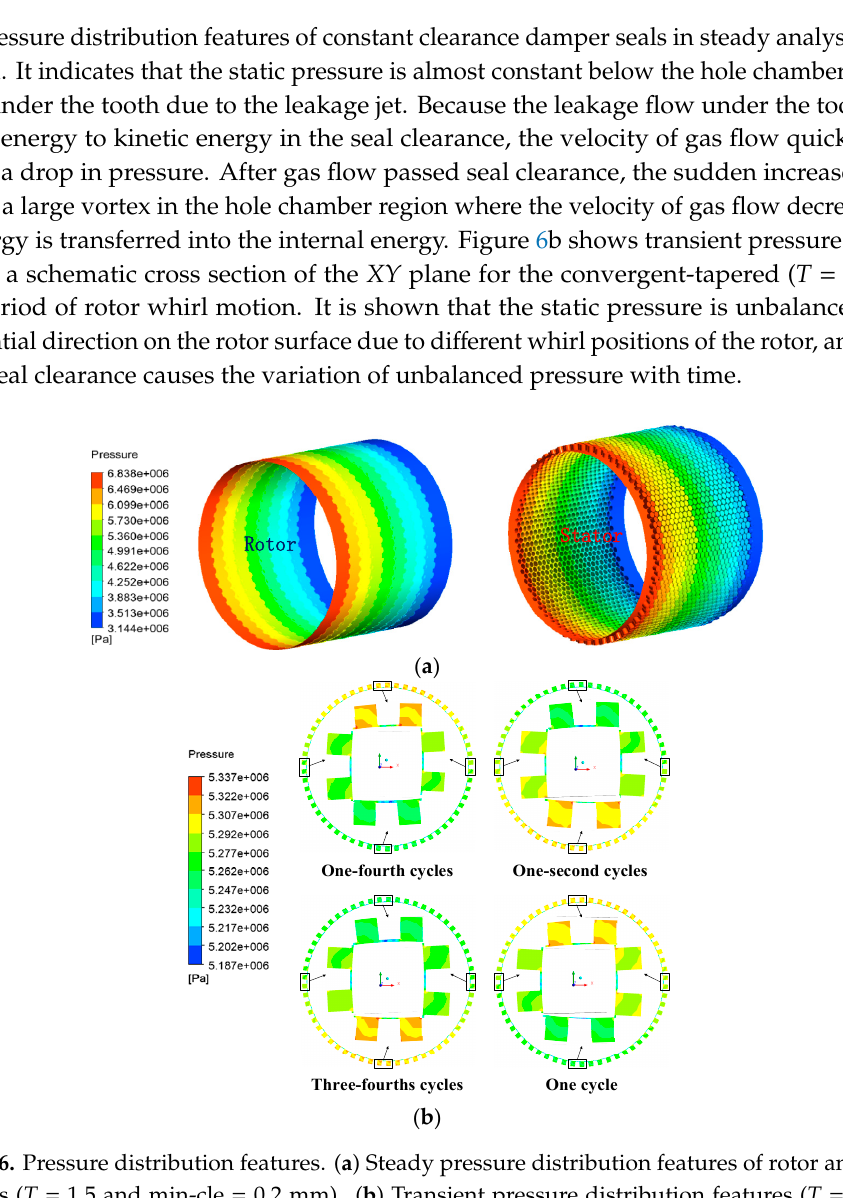
Figure 6. Pressure distribution features. ( a ) Steady pressure distribution features of rotor and stator surfaces ( T = 1.5 and min-cle = 0.2 mm). ( b ) Transient pressure distribution features ( T = 1.5 and min-cle = 0.2 mm).